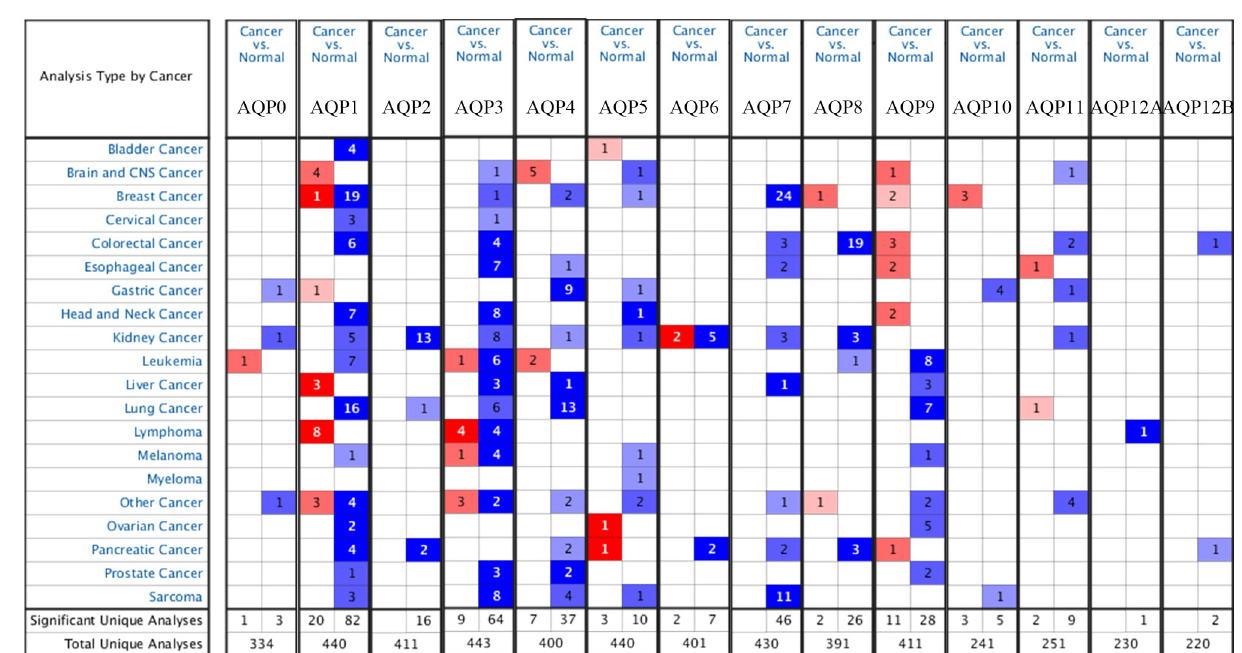
Fig 1. Transcriptional expression of AQPs in 20 different types of cancer diseases (Oncomine). The numbers in the small boxes represent the number of datasets with statistically significant mRNA differences of the target genes, in which red represents over-expression and blue represents down-regulated expression. Differences in transcriptional expression between ccRCC and normal kidney tissues were compared by students’ t-test. The cut off of p-value and fold change were as following: p-value: 0.01, fold change: 2, gene rank: 10%, data type: mRNA.